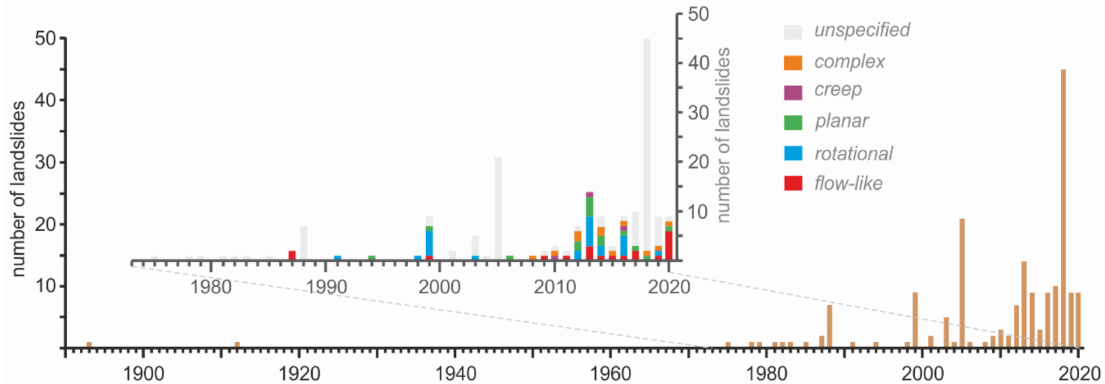
Figure 5. The chronological number of landslides analysed by dendrogeomorphic methods including the type of stud- ied